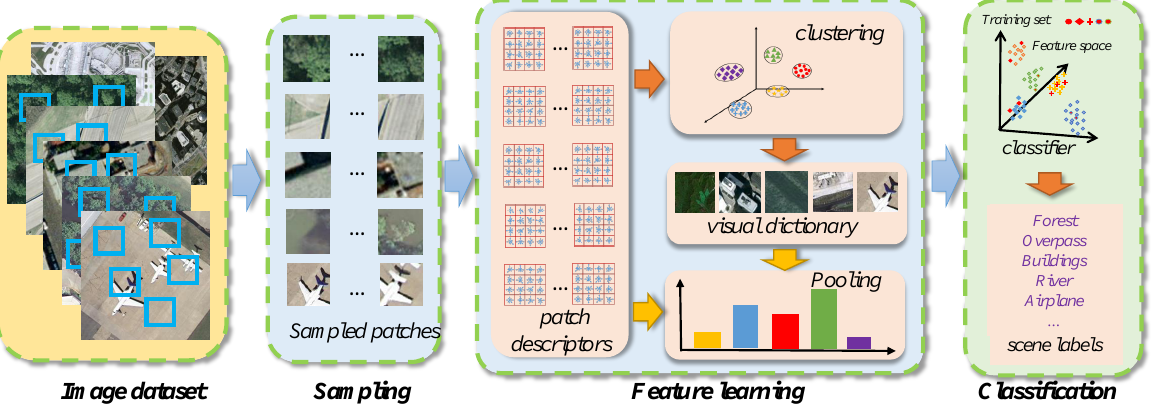
Figure 1. Flowchart of the comparative study scheme. It consists of three main